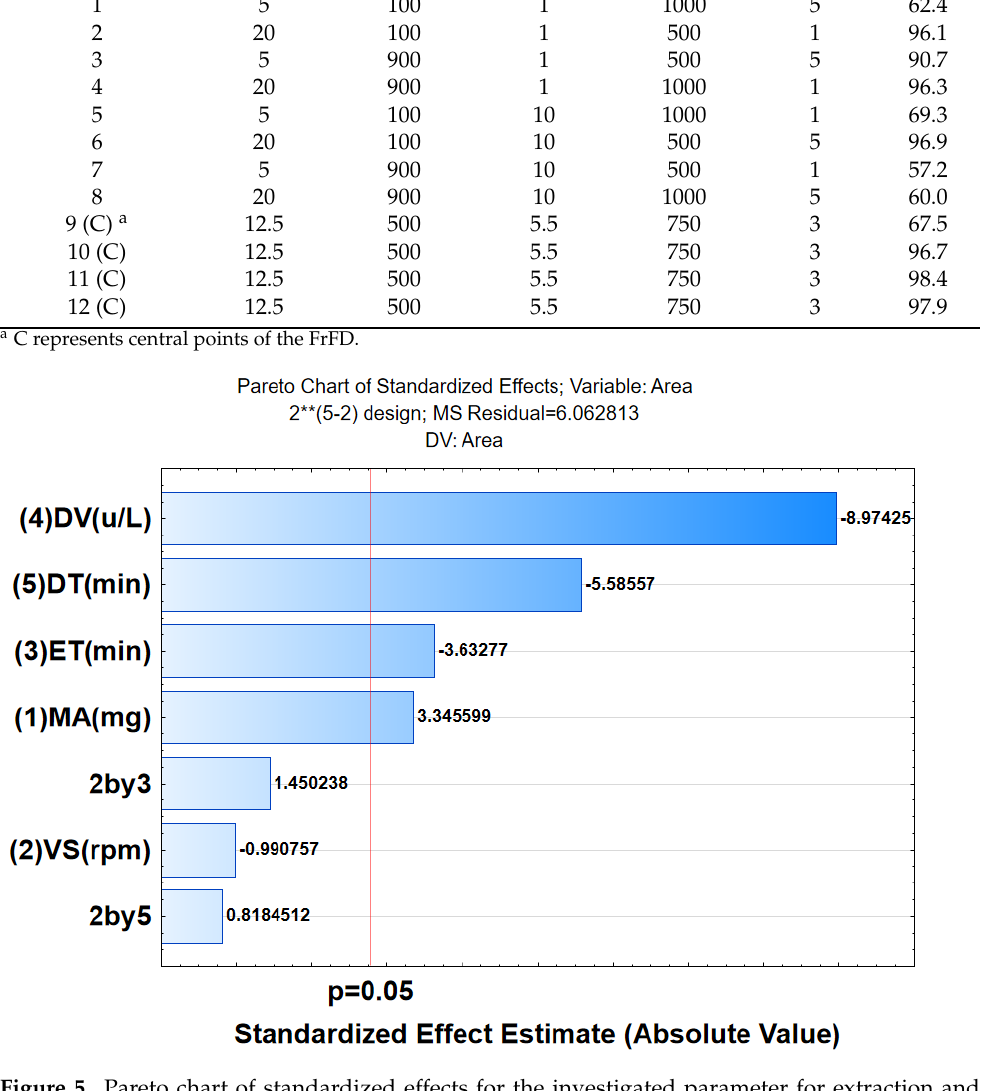
Figure 5. Pareto chart of standardized effects for the investigated parameter for extraction and pre-contraction of